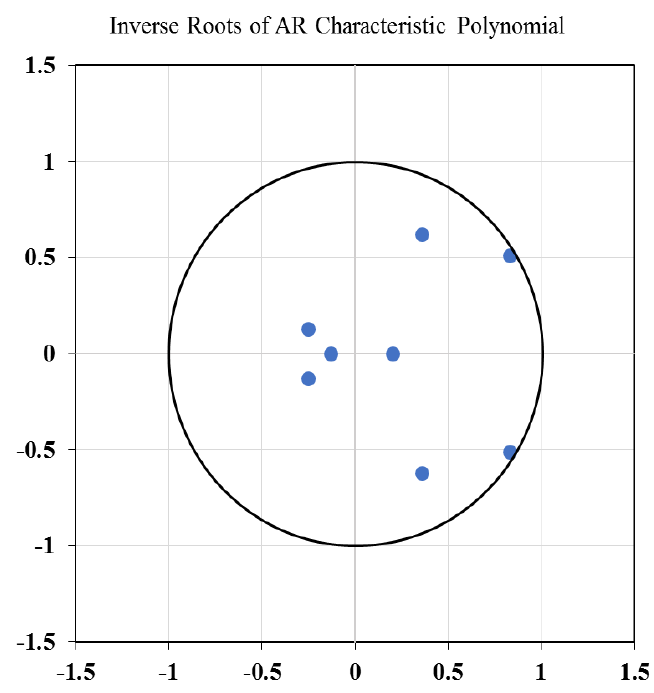
Figure 8. Stationarity test based on the VAR model constructed by four groups of factors.